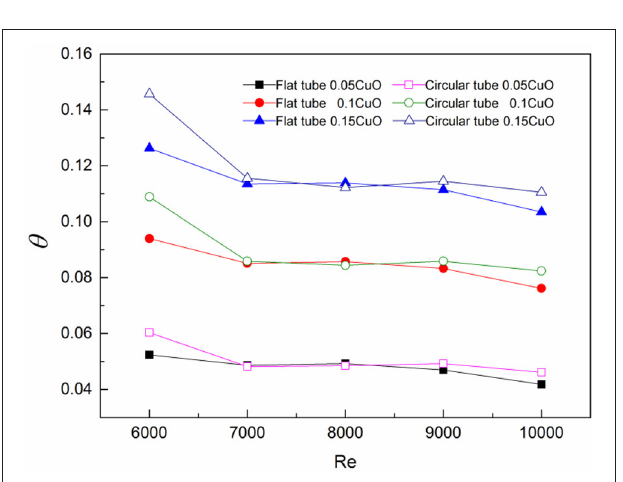
FIGURE 9 | Comparison of the radial temperature along the section of two